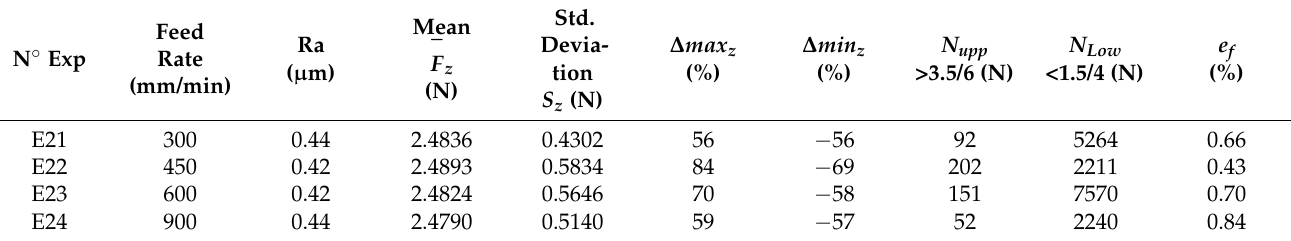
Table 5. Test results for the cut feed variations.